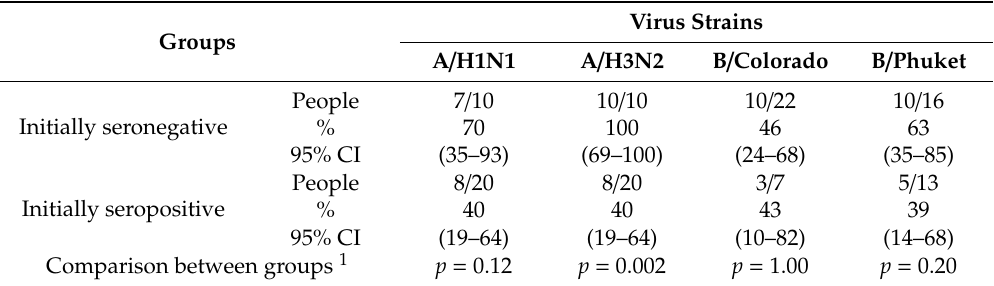
Table 2. Seroconversion level given the initial level of antibodies in the group of healthy